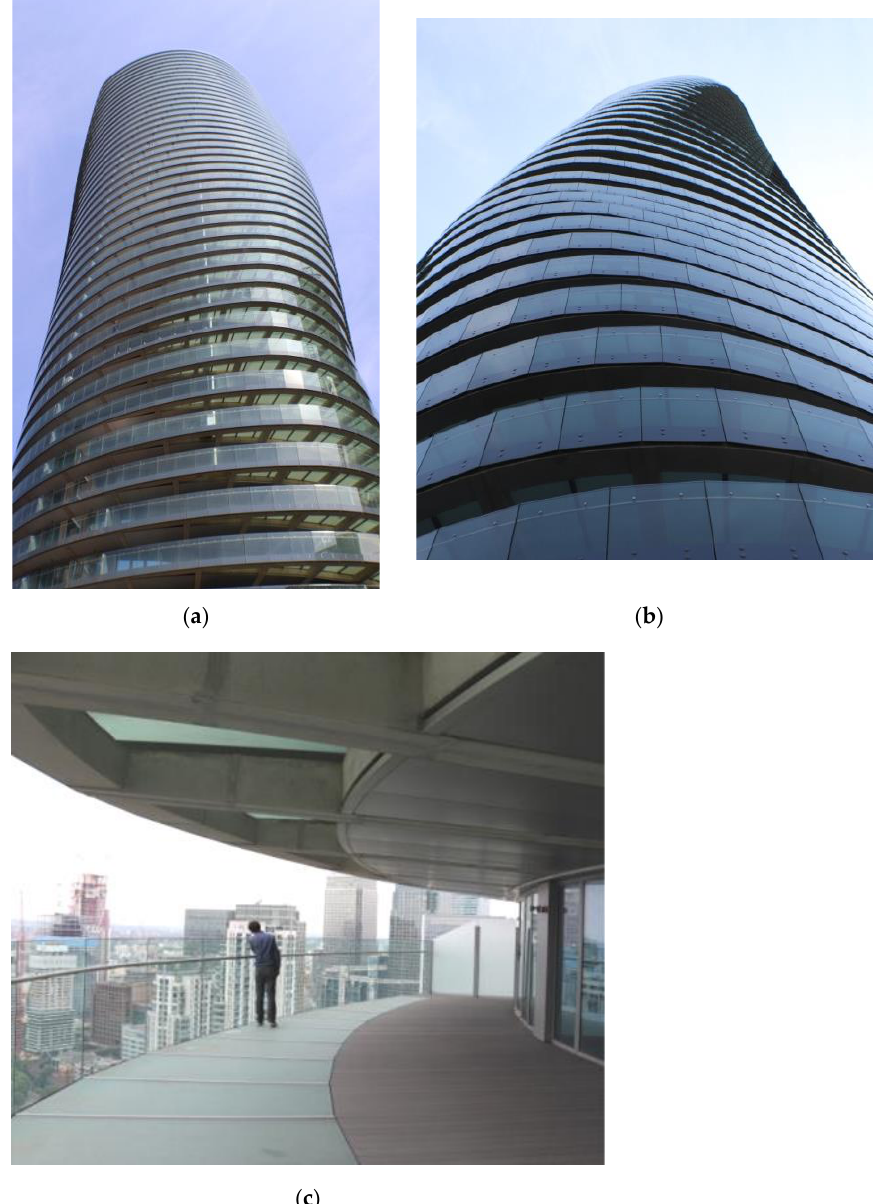
Figure 11. Sunshine as a deconstructing factor, Baltimore Wharf example. ( a ) Silhouette of the tower in good lighting conditions (2019), ( b ) Close up of the tower in poor lighting conditions (2020); ( c ) Detail of terraces in poor lighting conditions (2019).